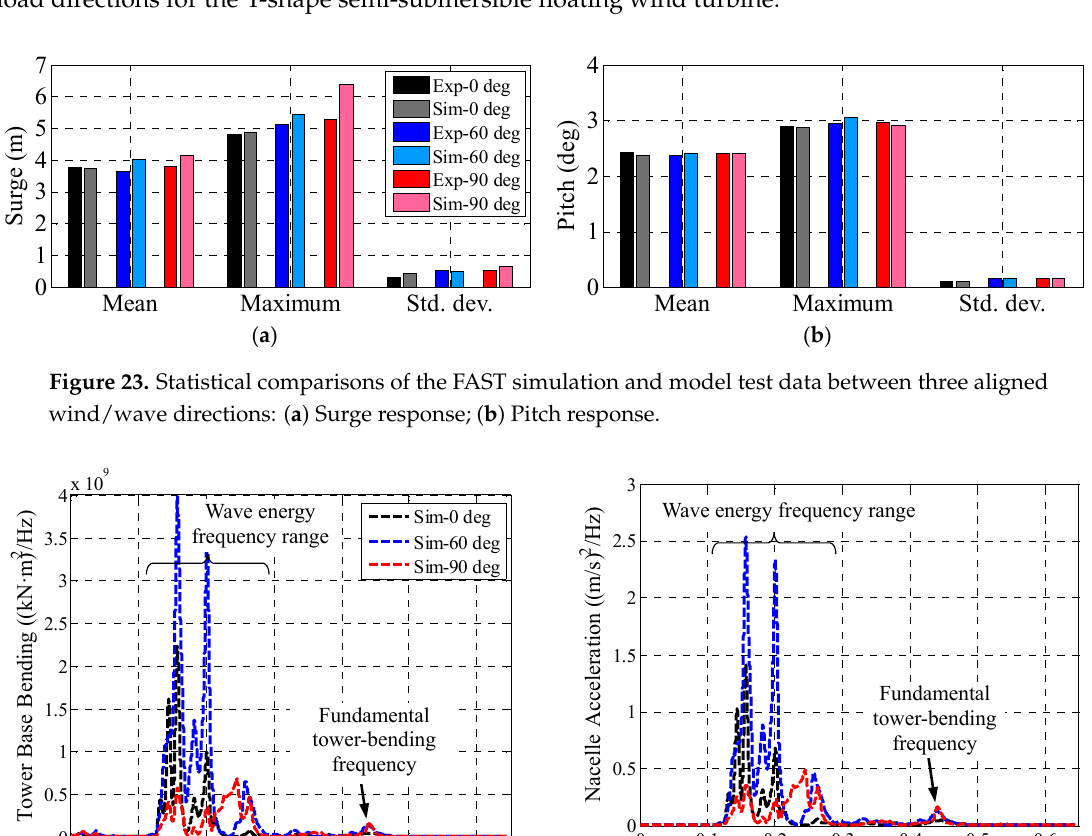
Figure 23. Statistical comparisons of the FAST simulation and model test data between three aligned wind/wave directions: ( a ) Surge response; ( b ) Pitch response.